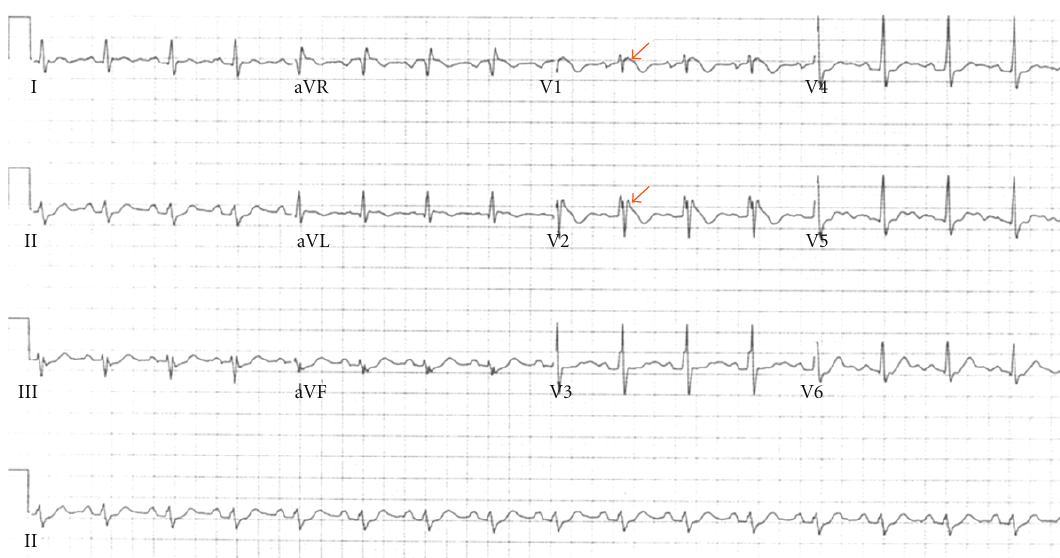
Figure 1: ECG upon admission demonstrating ST-segment elevations in leads V1 and V2 and incomplete right-bundle-branch block pattern, findings consistent with Brugada type 1 pattern. The patient was febrile to 103 ◦ F when this ECG was performed.